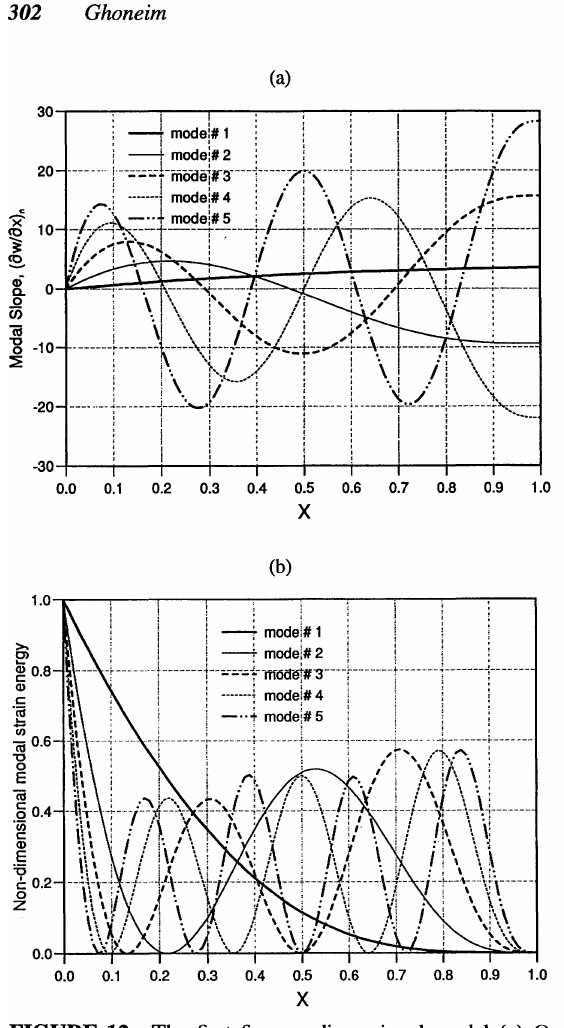
FIGURE 12 The first five nondimensional modal (a) e diagram and (b) strain energy diagram of a cantilever